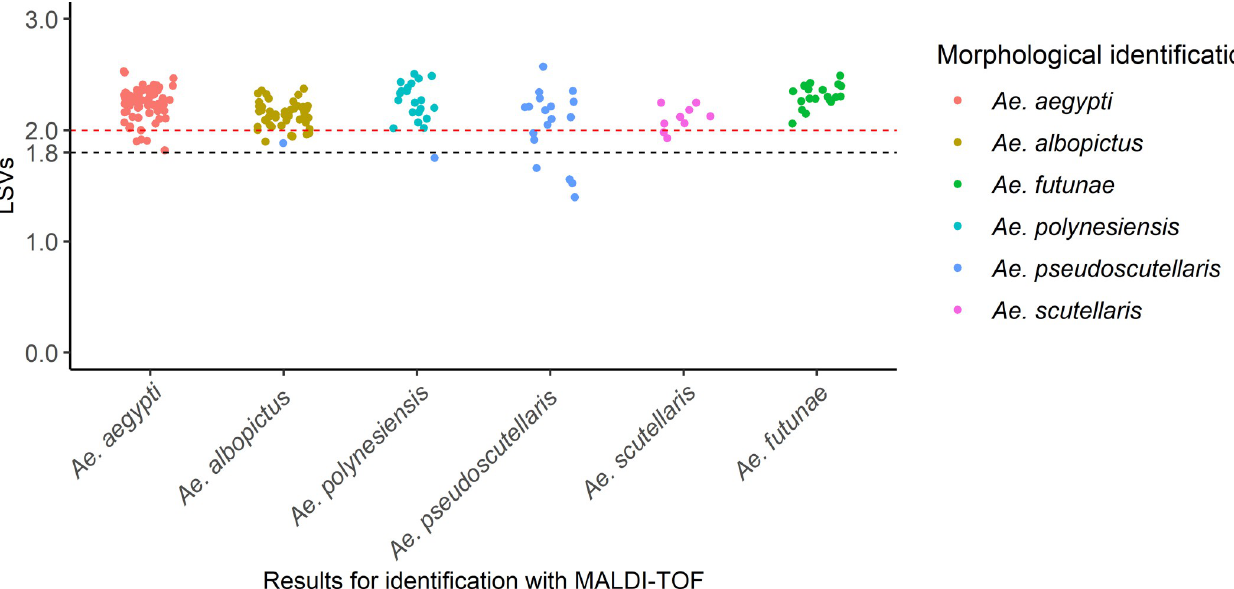
Fig 1. Comparison of the results obtained with morphological identification and MALDI-TOF analysis for the Aedes species. X-axis corresponds to the results obtained with MALDI-TOF analysis. Y-axis corresponds to Log-score values (LSVs). Colors illustrate morphological identification obtained through double-blind evaluation and confirmed with DNA sequencing for the Aedes of the Scutellaris Group. Black dashed-line corresponds to the threshold value for mosquito species identification, stated during previous study [29]. Red dashed-line corresponds to the threshold value for the identification of mosquito species belonging to the Scutellaris